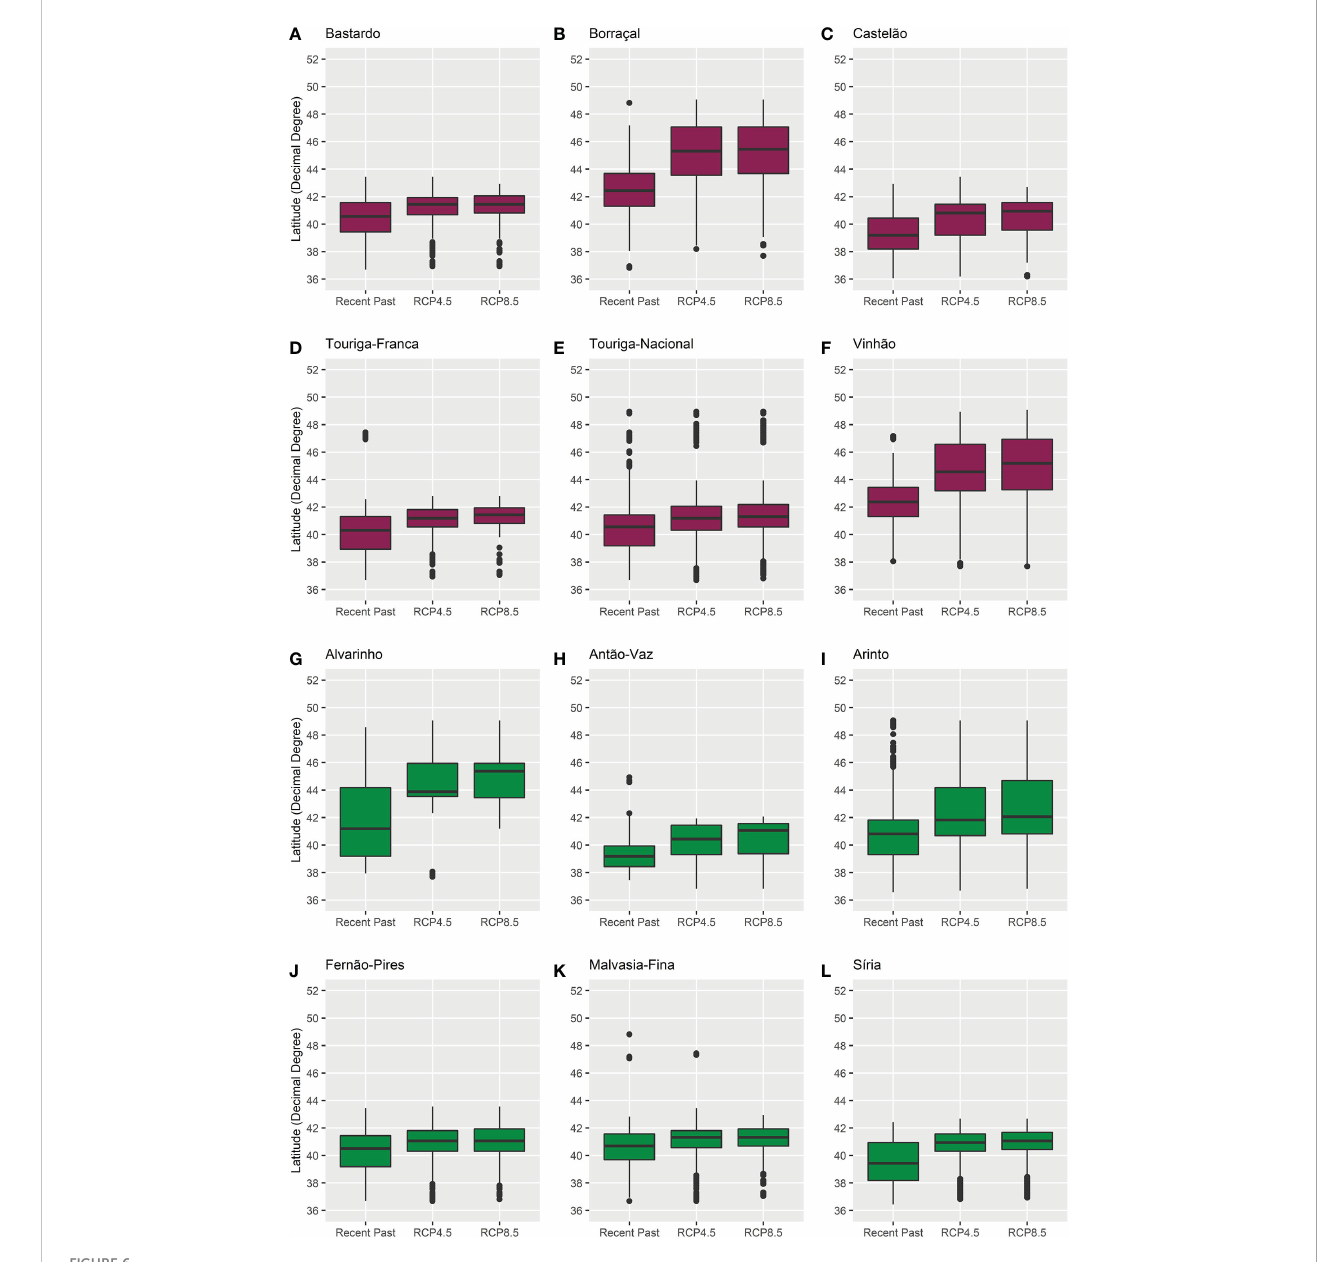
FIGURE 6 Boxplots of the distribution of bioclimatic suitability, above 20% probability of occurrence, in regards to latitude, for varieties (A) Bastardo, (B) Borrac ̧ al, (C) Castelão, (D) Touriga-Franca, (E) Touriga-Nacional, (F) Vinhão, (G) Alvarinho, (H) Antão-Vaz, (I) Arinto, (J) Fernão-Pires, (K) Malvasia-Fina, and (L) S ı ́ ria, in the recent past (1989 – 2005) and future (2021 – 2050) climates. Red boxplots identify red varieties and green boxplots identify white